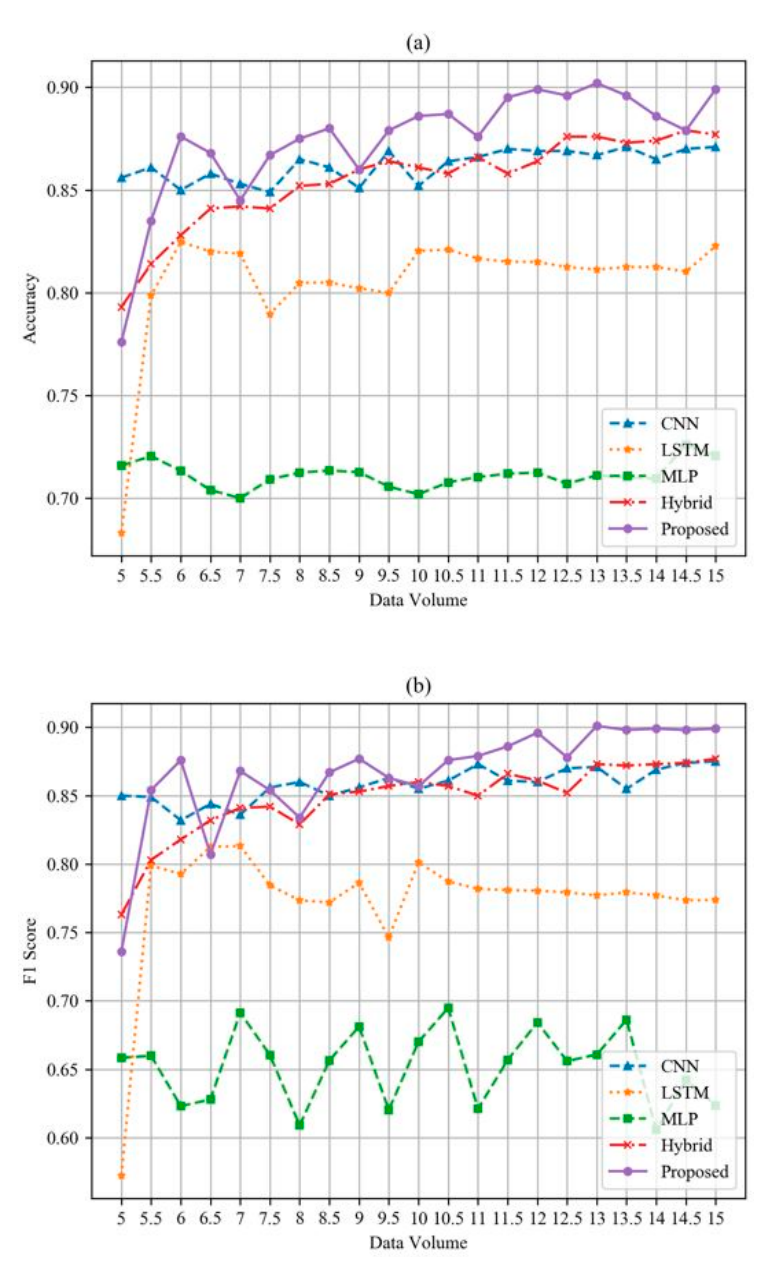
Figure 6. Model performance as data volume increases: ( a ) Accuracy; ( b ) F1 Score.